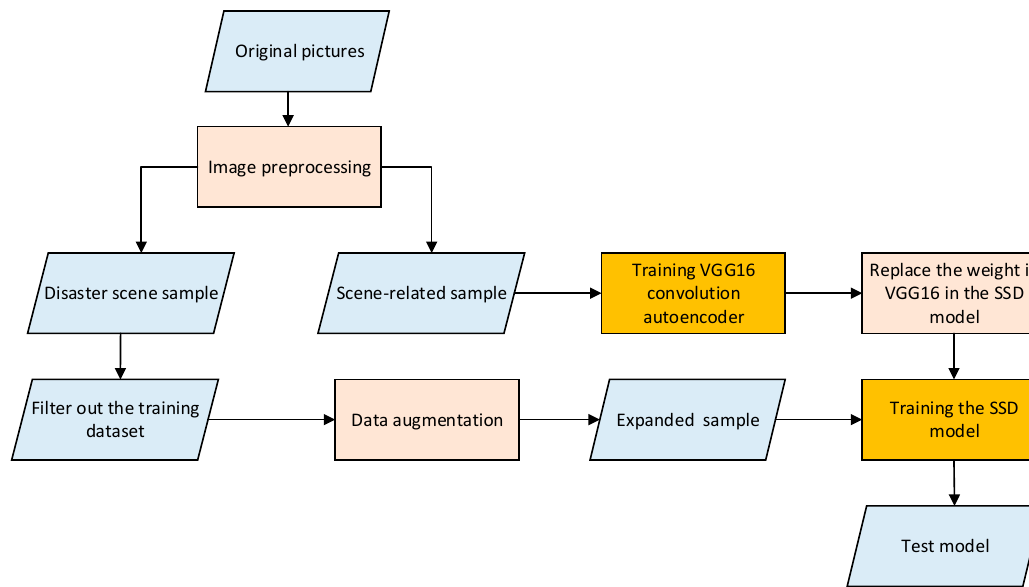
Figure 5. Scheme for model training with few training sets. Train the VGG16 convolution autoencoder was done with data related to the scene. The weight of its training was to initialize the VGG16 part of the SSD. Finally, the training dataset trained the SSD model after data augmentation processing.